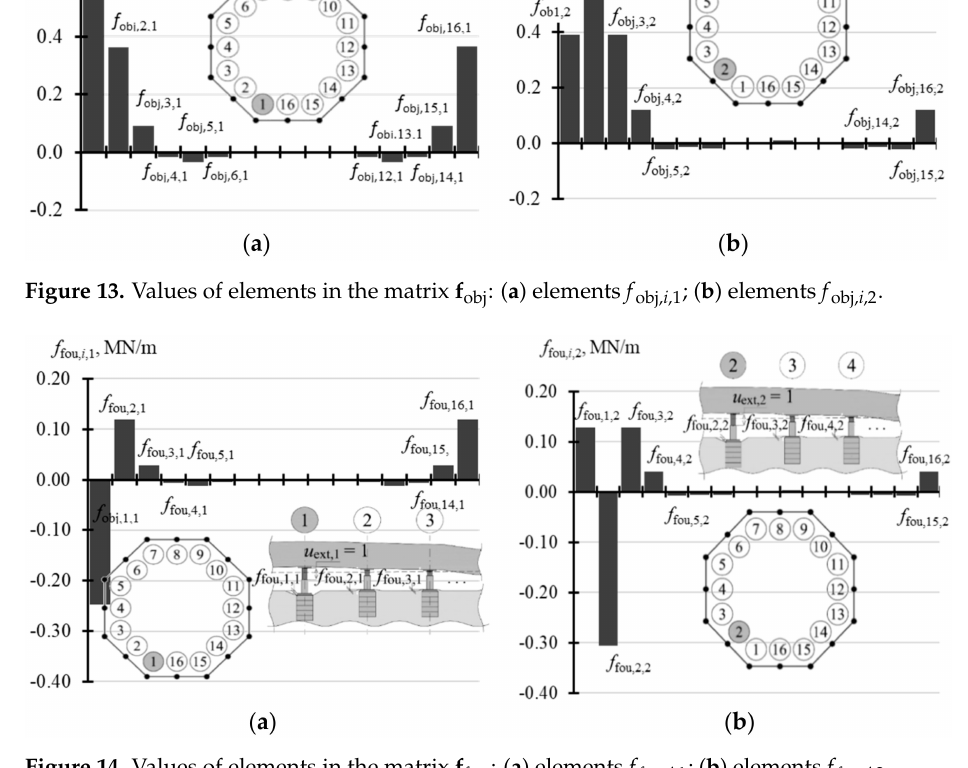
Figure 14. Values of elements in the matrix f fou : ( a ) elements f fou, i ,1 ; ( b ) elements f fou, i ,2 . The analysis of Figure 12 indicates that stiffness k 2,2 was greater than stiffness k 1,1 . force. Simultaneously, a drop in the force was observed for the adjacent passive